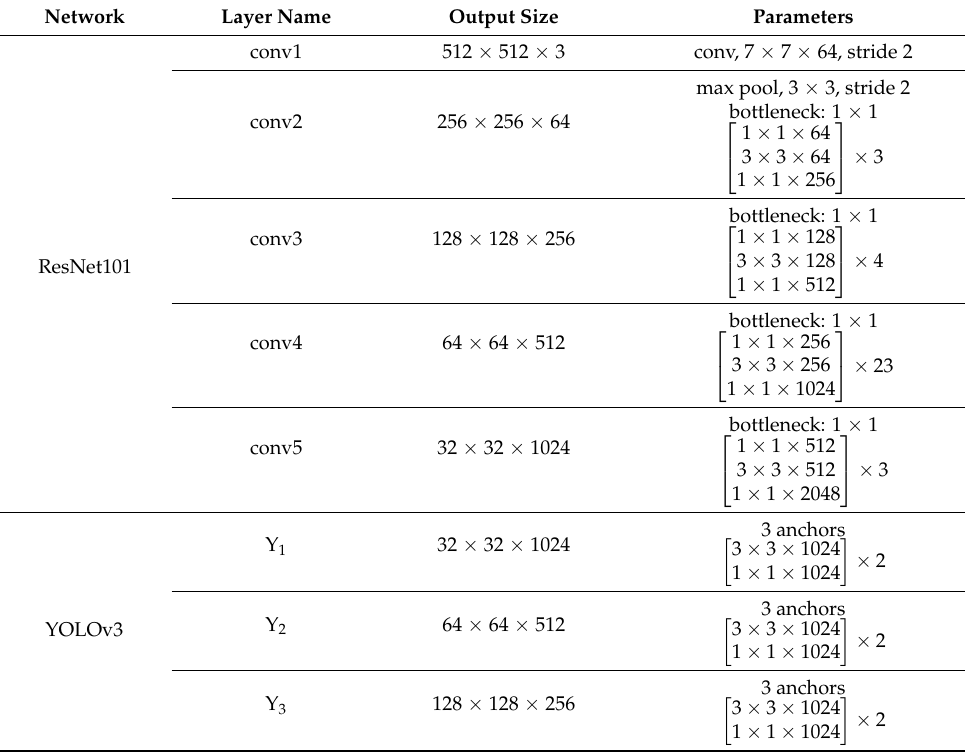
Table 4. Network parameters of YOLOv3–ResNet101.